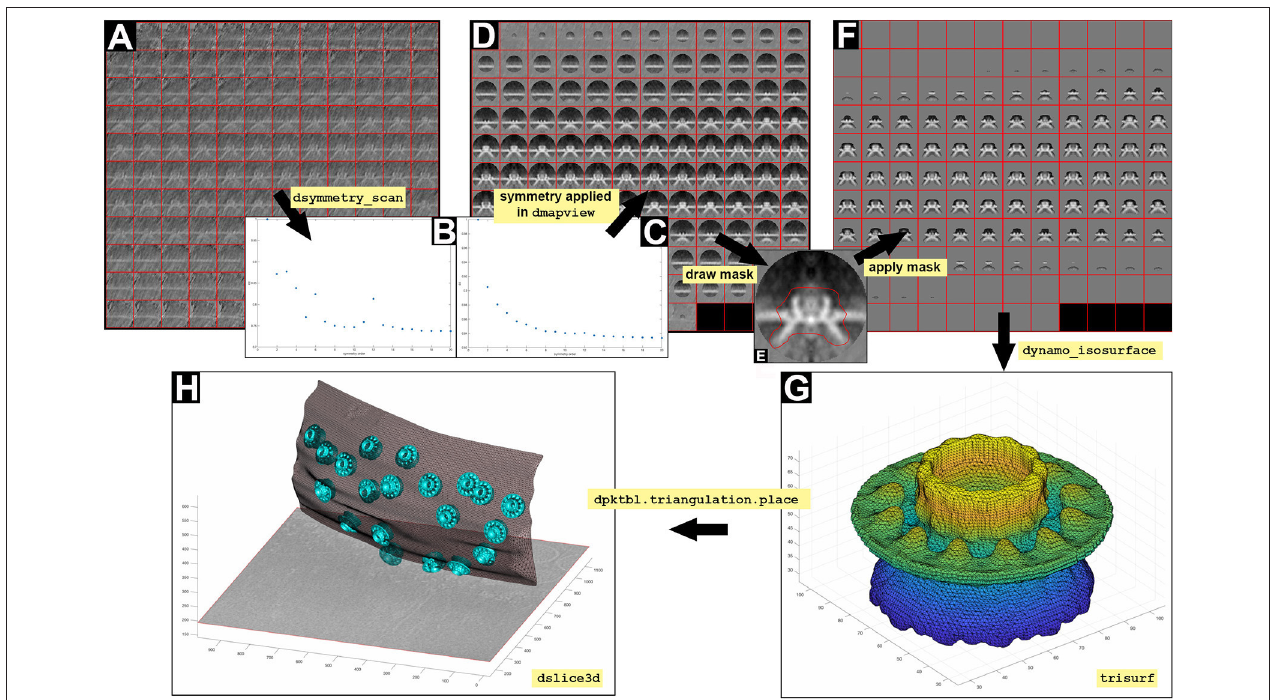
FIGURE 7 | Visualization of 3D scenes from Dynamo models and density maps. (A) Y view of the average obtained by executing the STA project localized . (B,C) Graphical representation of symmetry (dsymmetry_scan) found in (A) with and without applying the mask file teethMask.em, respectively. (D) Y view of the c12 symmetrized average obtained by executing the STA project localized . (E) Y view of the slice number 65 of the average obtained by executing the STA project localized . The mask is defined by manually drawing an area covering the crown structure (red line). (F) Y view of the c12 symmetrized average obtained by executing the STA project localized STA after application of the mask defined in (E) . (G) Graphical reconstruction using trisurf of the structure of the crown as a triangulated surface (dynamo_isosurface) . (H) 3D displayed (dslice3d) of the crown particles (cyan surface) inserted in the OMM (gray triangulated surface, dpktbl.triangulation.place ) in the